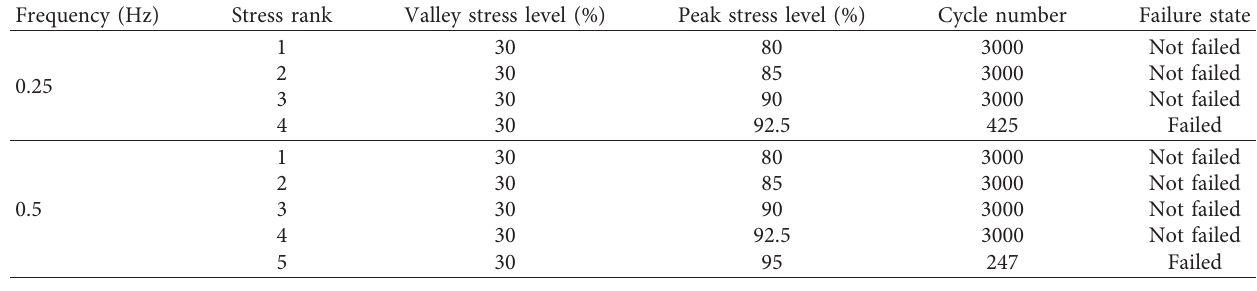
Table 2: Test schemes and results of representative specimens subjected to cyclic loading under the confining pressure of 10MPa. Frequency (Hz) Stress rank